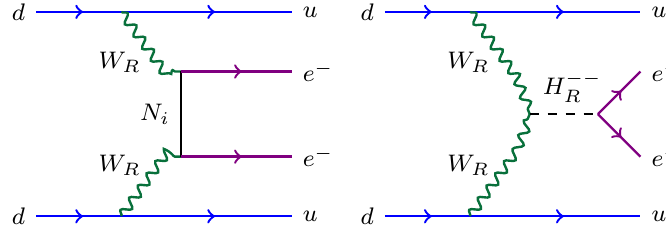
Figure 17 . Additional Feynman diagram in the LRSM (in addition to (cid:12)gure 3) for the parton-level 0 (cid:23)(cid:12)(cid:12) , induced respectively by the heavy RHNs N i (left) and the RH doubly-charged scalar H (cid:6)(cid:6) (right), which correspond respectively to the amplitudes (cid:17) N and (cid:17) R